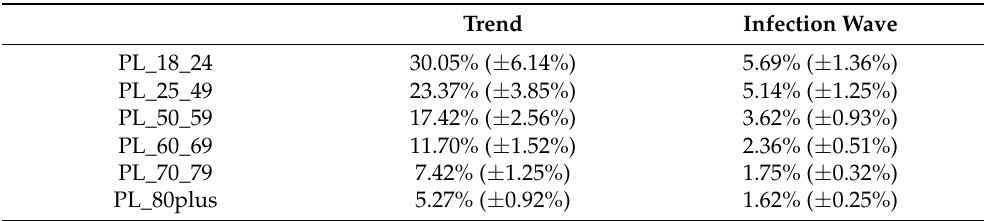
Table 1. Polish unweighted province average ( ± 1 standard deviation) of the percentage of people, subdivided into age groups, who received the first dose of the COVID-19 vaccine in the period 2021-W22 to 2022-W21, split according to implied motivation mechanisms.